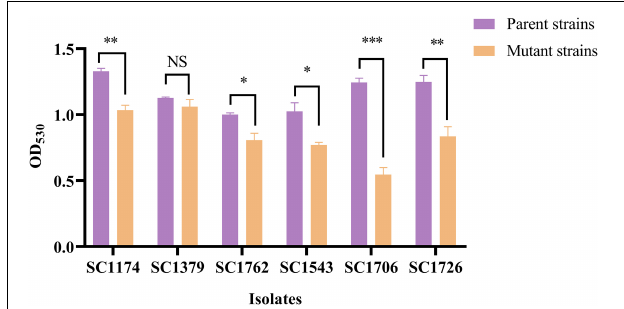
FIGURE 3 | Relative positive surface charge examined based on cytochrome C binding. Evolved DAP-R mutants, except SC1379-D, had less free cytochrome C in the supernatant than their parental strains, indicating that they carried more net positive charge. Data are presented as mean values with error bars indicating standard deviations of the means of results from duplicate experiments, and P- values were calculated by the paired Student’s t -test (* P < 0.05; ** P < 0.01; and *** P < 0.001; NS means no significant difference).